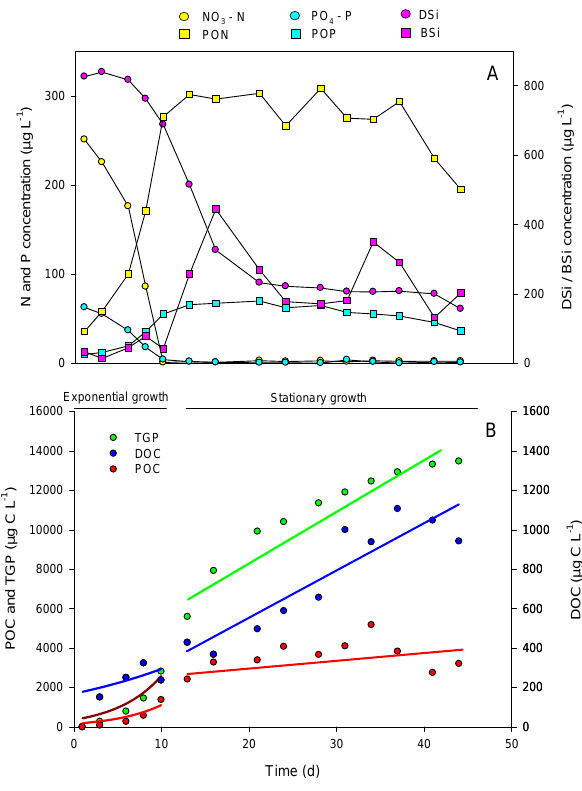
Figure 1. An example of the data extracted from the mesocosms (data from high-light treatment with N and P addition, 2004): dis- solved, inorganic nutrients and particulate, organic nutrients (a) and carbon parameters (b) . The parameters are nitrate (NO 3 ) , particu- late organic nitrogen (PON), phosphate (PO 4 ) , particulate organic phosphorus (POP), dissolved silicate (DSi), biogenic silicate (BSi), particulate organic carbon (POC), dissolved organic carbon (DOC), and total gross production (TGP). All parameters were measured directly except TGP, which was extrapolated from short-term 14 C incubations. The growth was divided into exponential and stationary growth phases based on the primary production peak (L − 1 ) , indi- cated with the horizontal bars on top (b) . Note the different scales on the y